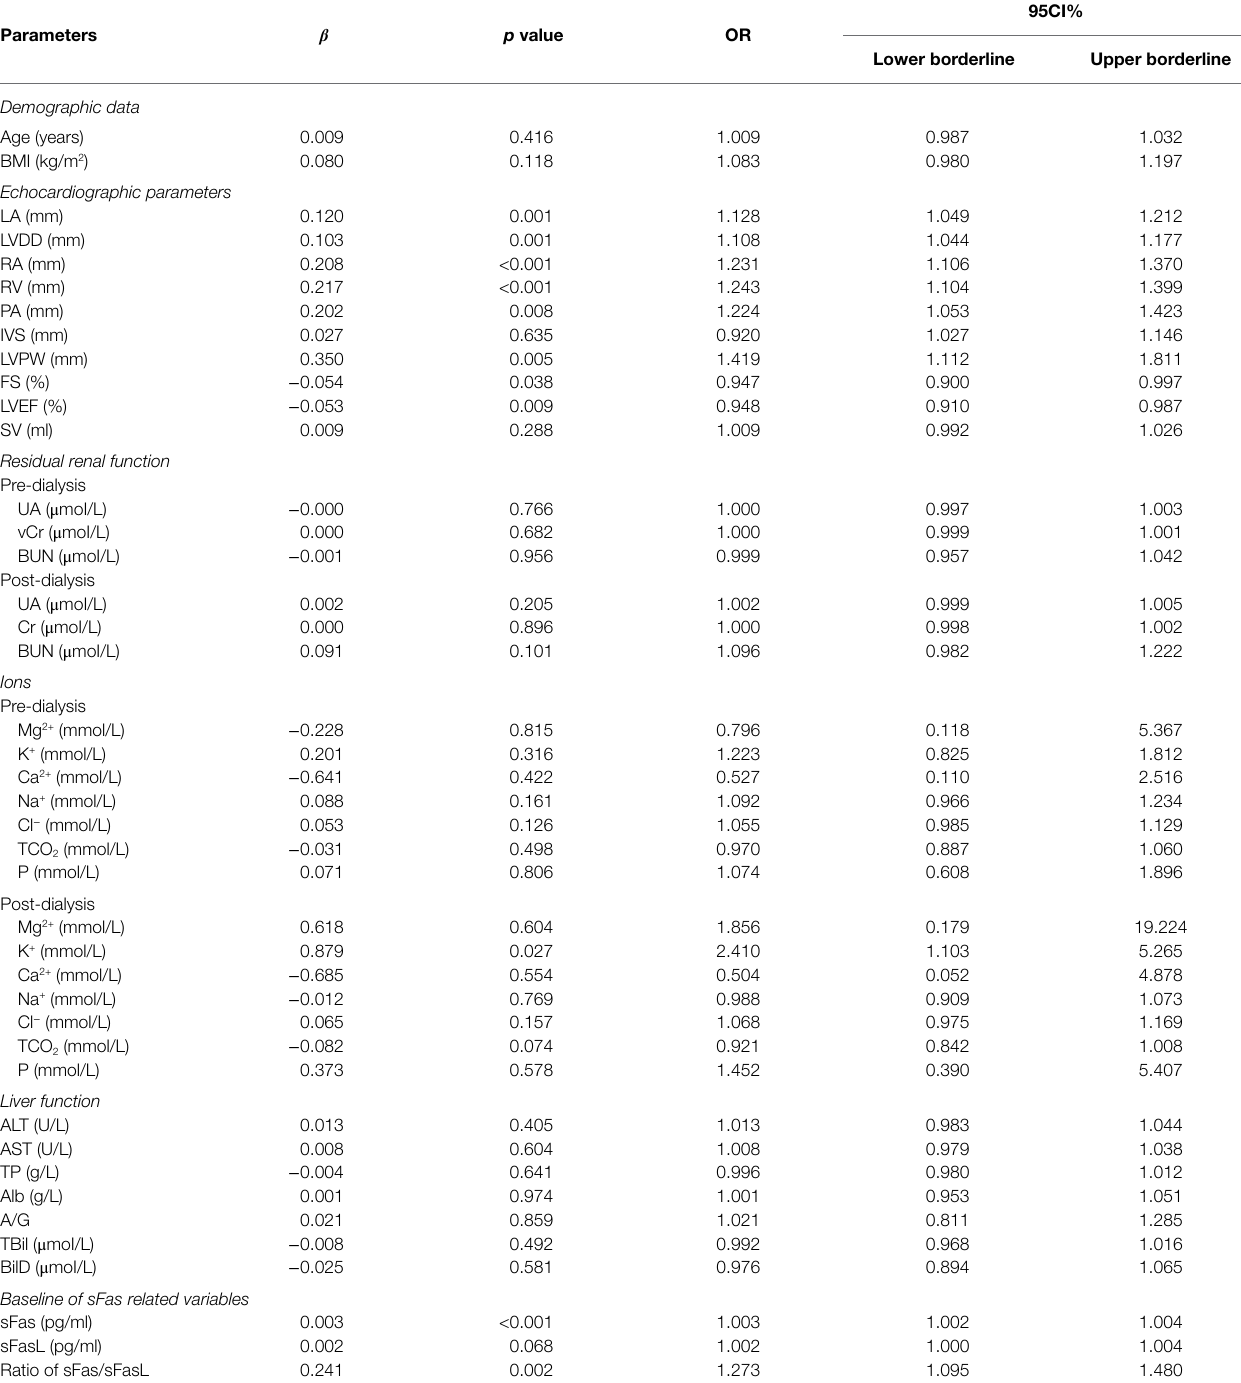
TABLE 3 | Univariate logistic analysis for